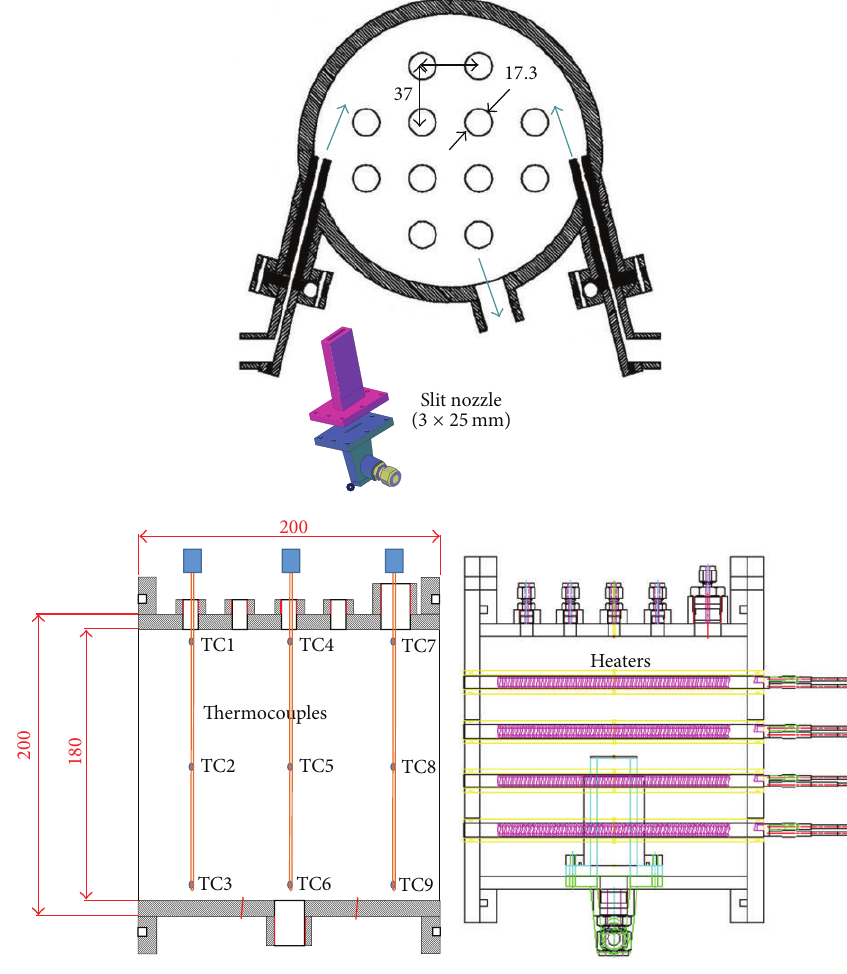
Figure 2: Test section and the measurement points.